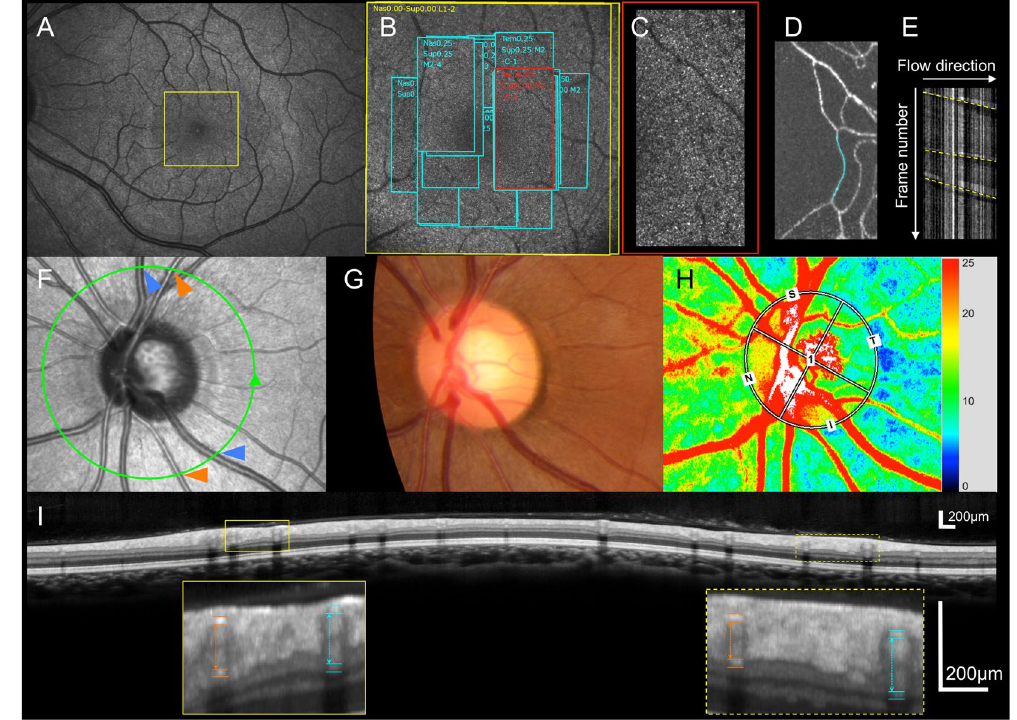
Figure 1. An example of three types of measurements in a normal subject. ( A ) Wide field scanning laser ophthalmoscopy (SLO) image. The detailed scanning area is indicated with a yellow outlined rectangle. ( B ) Adaptive optics SLO (AOSLO) image as shown by the yellow outlined rectangle in A . Rectangular areas outlined in aqua and red indicate locations of AOSLO video recording. ( C ) An AOSLO image as shown by the red outlined rectangle in ( B ). ( D ) A montage image obtained from AOSLO video using motion contrast enhancement technique. The target vessel is shown in aqua. ( E ) A spatiotemporal image of the target vessel shown as aqua in ( D ). The longitudinal axis represents frame number of consecutive images, and the horizontal axis represents vessel length and flow direction. White bands represent leukocytes and following dark bands represent aggregated erythrocytes in the capillary vessel. Dotted yellow lines indicate anterior ends of aggregated erythrocytes. Reciprocals of the slope of the lines represent parafoveal blood flow velocity (pBFV). ( F ) An SLO image of the optic disc. ( G ) Fundus photograph around the optic disc. ( H ) Laser speckle flowgraphy image around the optic disc. I , Circumpapillary scan of spectral-domain optical coherence tomography shown as the green circle in ( F ). The top and the bottom of vessel walls are depicted as hyper-reflectivities. Arterial and venous inner diameters are shown as orange and aqua dotted double-headed arrows,